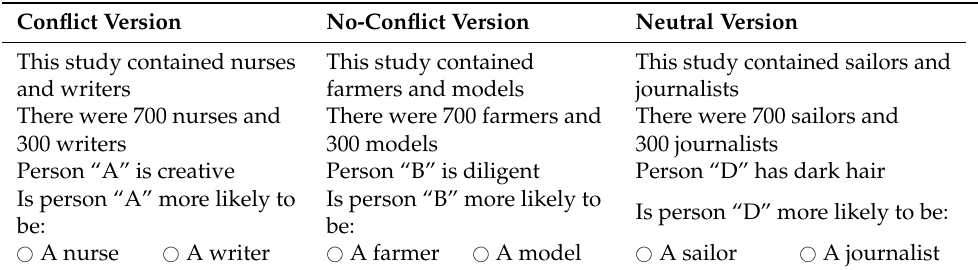
Table 1. Examples of conflict, no-conflict, and neutral versions of base-rate